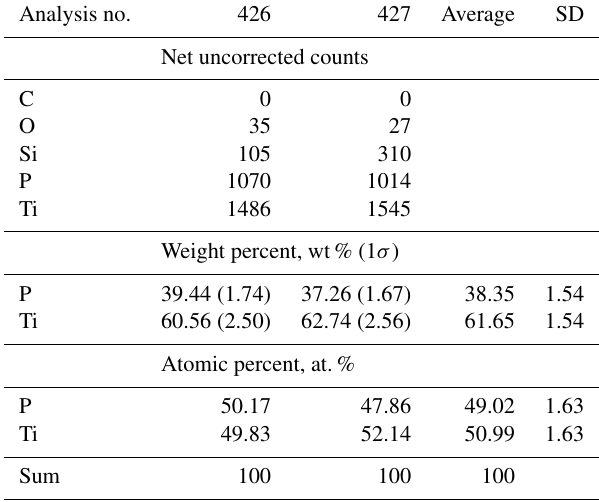
Table 2. Energy-dispersive spectroscopic (EDX) analyses of badengzhuite in foil no. 5358. Analysis